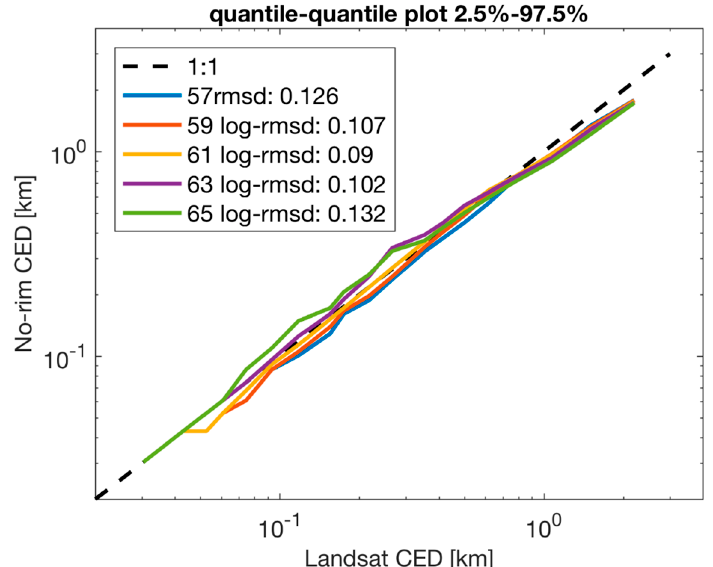
Figure A8. Quantile-quantile plot comparing 2.5th to 97.5th quantiles of TSI-like to full Landsat CED distributions drawn from cloud size distributions (Equation (2)). Colored lines indicate the minimum zenith angle that a cloud must subtend to be included. A minimum zenith angle of 65° (green) includes all clouds and shows that the TSI-like over-estimates clouds under 0.6 km. Minimum zenith angles of 63° (purple) and 61° (yellow) show good agreement for clouds with CED < 1 km, while minimum zenith angles of 59° (red) and 57° (blue) underestimate clouds under 0.6 km. All TSI-like observations underestimate large clouds with CED > 0.8 km; this cannot be improved by removing rim clouds. The log-root mean squared difference is computed for each population, indicating that 61 ° shows the best agreement.